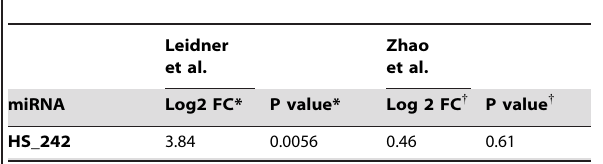
*Log2 fold change and p-value of our top 34 miRNAs; { Log2 fold change and unadjusted p-value from GEO2R for differential expression between cases and controls in Zhao et al. sample.